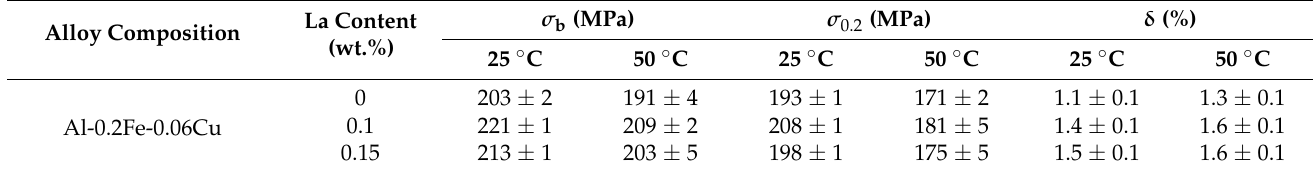
Table 2. Mechanical properties of foil the alloys under different conditions. Alloy